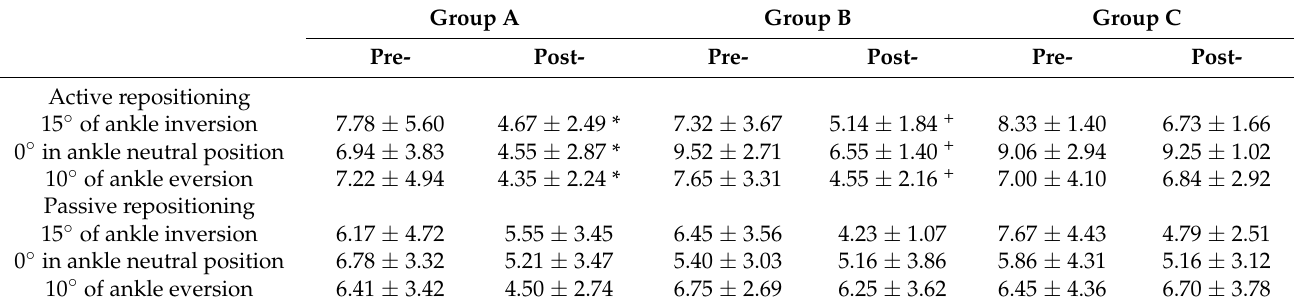
Table 5. Results of joint position sense measurements in three